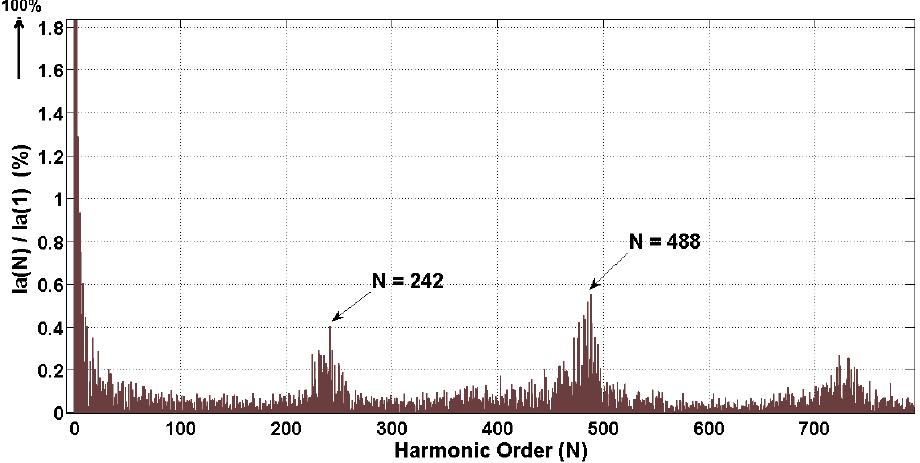
Figure 23. Harmonic content for line current i a .